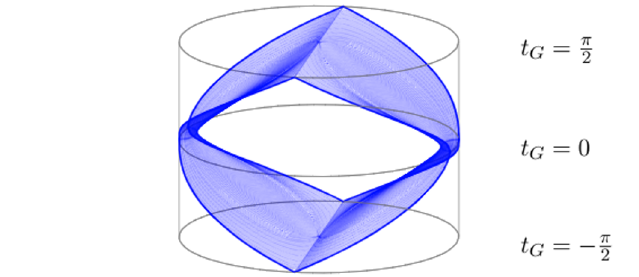
Figure 8. A global solution with two BCFT-bits. The state at t G = 0 is prepared by removing two disk shaped regions from the Euclidean path integral. The brane trajectories ensure there is no causal curve connecting the two BCFTs. The geometry to the future and past of the ETW branes is